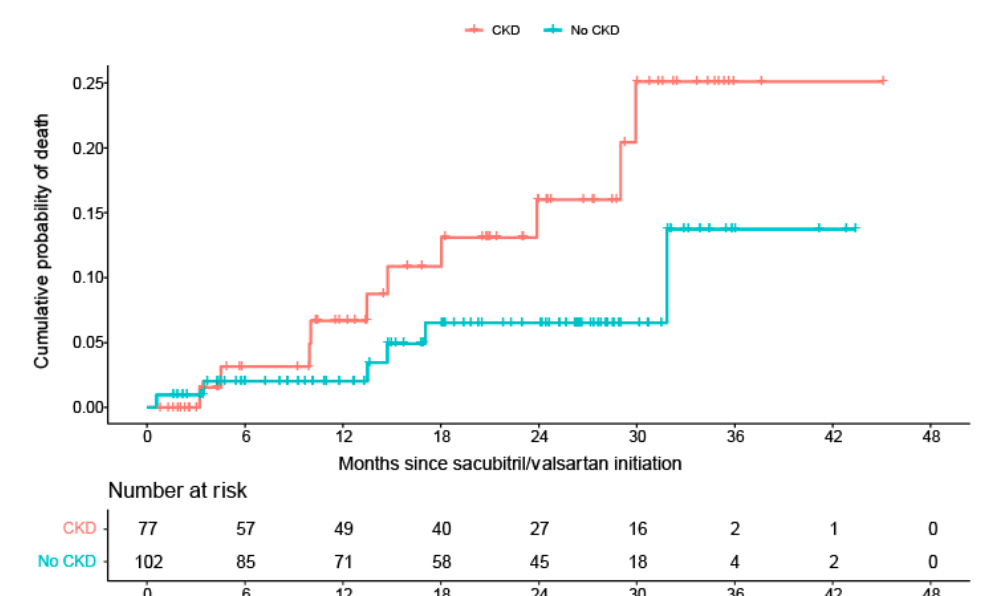
Figure 1. Kaplan–Meier Curves for all-cause mortality stratified by CKD at baseline. CKD: chronic kidney disease (eGFR < 60 mL/min/1.73 m 2 ); eGFR: estimated glomerular filtration rate.